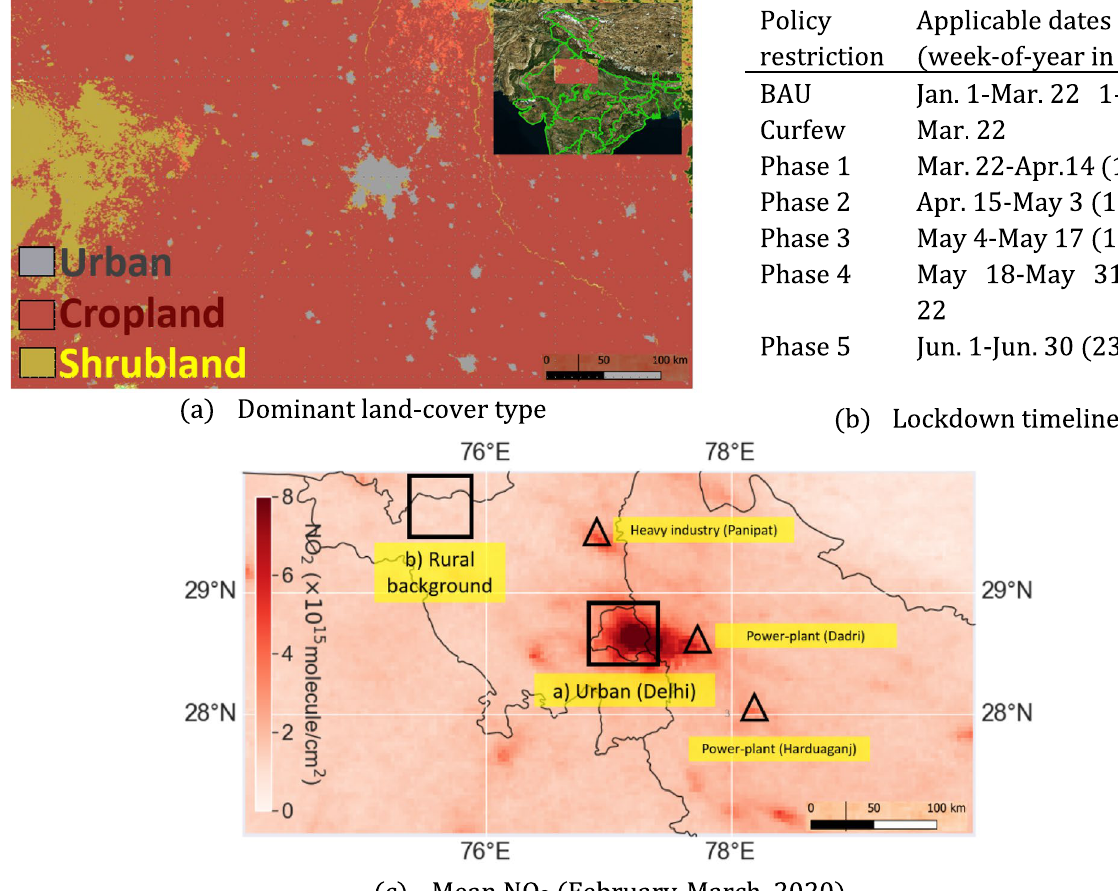
Figure 1. ( a ) Dominant land cover types in the study domain (74°E, 27°N—80°E, 30°N) are urban areas, croplands and desert shrublands. ( b ) Timeline of lockdown policies, where BAU refers to business-as-usual conditions (for details see Table S1). ( c ) Mean NO 2 column density (TROPOMI) during February 1 to March 20, 2020. Representative location of an urban area (Delhi) and rural background (Fatehabad) is shown in black box, in addition to other prominent emission sources (power-plant at Dadri and Harduaganj and an industrial cluster at Panipat) marked in a triangle. Figures generated using ‘Cartopy’ version 0.16 and ‘Rasterio’ version 1.2 modules of Python 3.6 (https:// www. python. org/ downl oads/ relea se/ python- TROPOMI is generally random. In comparison with OMI (‘OMNO2 ′ level 2 version 3.1 product), the bias of TROPOMI (offline level-2 product) is − 0.2 ± 0.8 × 10 15 (1σ) molec / cm 2 , which is − 6% ± 21%(1σ) in relative value 33 . OMI NO 2 ′ s level-3 daily gridded product (‘OMNO2d’ version 3) with a cloud fraction less than 30% and filtered for ‘row anomaly’ (see Section S2), was downloaded from NASA’s Giovanni portal 34 . From the Google Earth Engine cloud-platform 35 , TROPOMI’s tropospheric NO 2 (‘tropospheric_NO2_column_number_density’ band of ‘S5P_OFFL_L2_NO2 ′ product) was cloud screened (by discarding pixels with effective cloud fraction greater than 20%) and downloaded. The daily concentration (from Monday to Sunday) datasets were aggregated to weekly mean concentration to overcome the periodic weekly cycle of increase (on weekdays) and decrease (on weekends) in NO 2 concentrations 36 . For the study domain, the relative difference of NO 2 concentrations between 2020 and 2019 from the OMI and the TROPOMI was similar and within 5% of each other (see Section S3). Gridded meteorological data. Meteorological fields from National Center for Environmental Prediction (NCEP) FNL (Final) Operational Global Analysis and Forecast gridded datasets 37 are available every 6 h at a 0.25° × 0.25° spatial resolution. Horizontal wind field vectors ( w ), namely zonal ( u ) and meridional ( v ) components, at 80-m altitude were downloaded for 2019 and 2020. w was used for estimating NO 2 flux. To ensure the temporal com- patibility of the wind vectors with the satellite datasets for analysis, the meteorological datasets were interpolated to 13:30 local time. Wind vectors at a shallow elevation were considered to represent the advection of emission plumes close to the surface, such as vehicles and factories. The time series of meteorological parameters over Delhi (77°E, 28.5°N) is shown in Fig. S2.